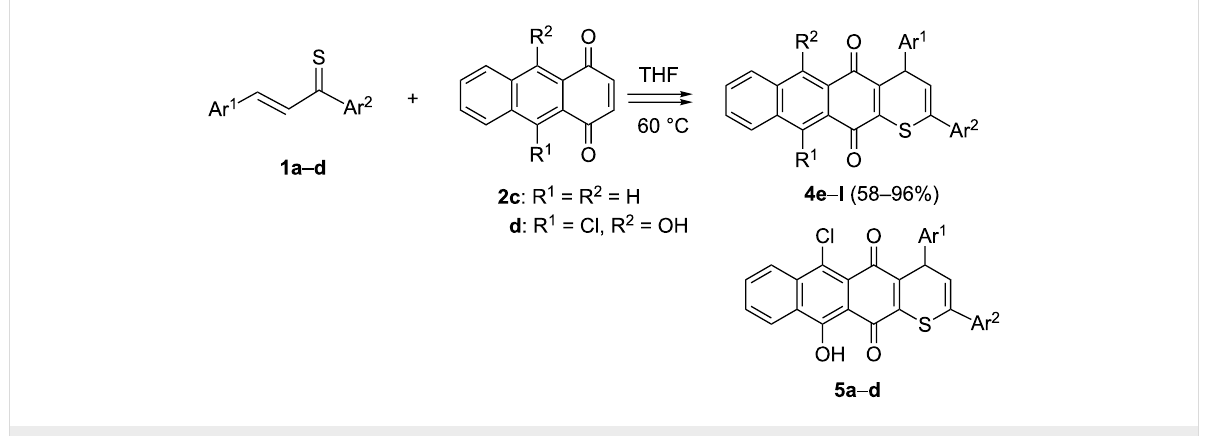
The crystal structure of 4k is that of the regioisomer proposed on the basis of reactivity considerations. Since the space group